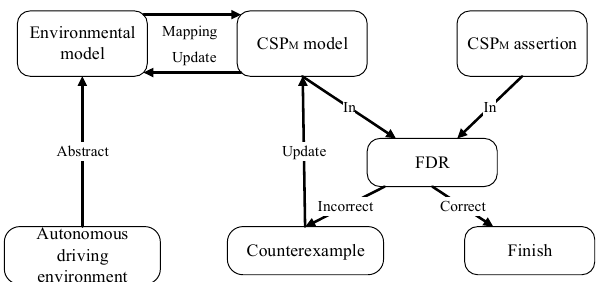
Figure 1. CSP M ‐ based modeling and verification framework for autonomous driving resource occu ‐ Figure 1. CSP M -based modeling and verification framework for autonomous driving resource pancy rules. occupancy